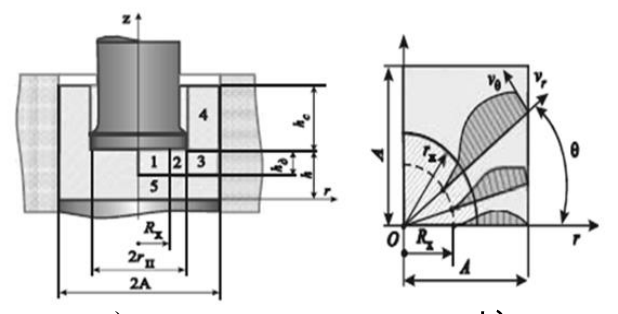
Fig. 4. The diagram of the division of the part into zones (a) and the diagram of the three-dimensional flow in zones 2 and 3 (b) at the second stage of